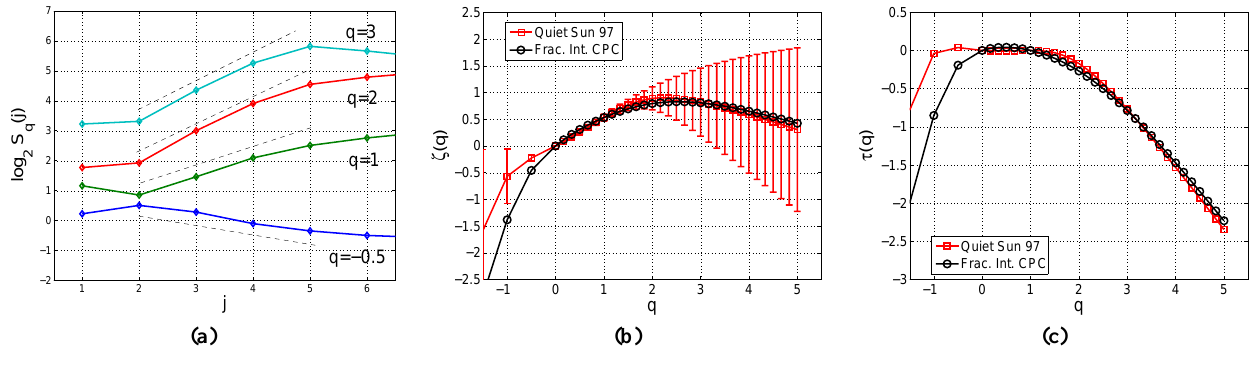
Fig. 4. (a) Structure function ( q =− 0 . 5 , 1 , 2 , and 3) estimated from DWT of Quiet Sun images in 1997. (b) Exponents ζ(q) obtained from the DWT structure functions, for the original Quiet Sun images, and for simulated images using Compound Poisson Cascades (c) Exponents τ(q) deduced from ζ(q) by τ(q) = ζ(q) − qζ( 1 ) .